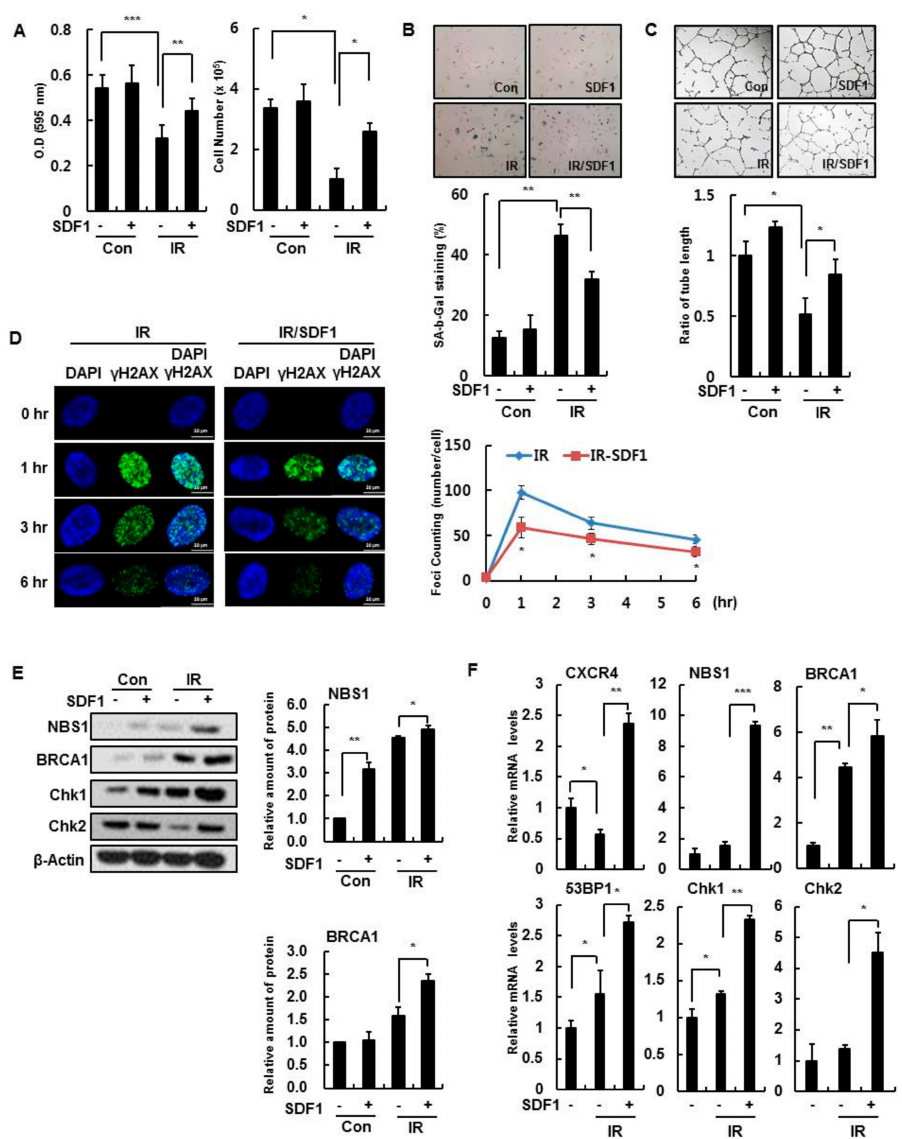
Figure 3. SDF-1 promotes recovery in damaged HBMVECs. ( A ) Cell viability was measured by a 3-(4,5-dimethylthiazol-2-yl)-2,5-diphenyltetrazolium bromide (MTT) assay, and cell proliferation was confirmed by cell count analysis. HBMVECs were pretreated with 50 ng / mL SDF-1 an hour before 4 Gy radiation treatment. MTT was measured 24 h after radiation treatment, and the cell count was analyzed after 4 days. ( B ) Cells were stained for SA- β -gal activity and evaluated using a light microscope (100 × ). Four days after irradiation, staining was performed to analyze SA- β -gal positive cells; results are expressed as a percentage. ( C ) Cells were pretreated with SDF-1 an hour before irradiation for 24 h. Cells were placed on Matrigel, and tube formation was measured after incubating for 8 h. ( D ) HBMVECs were treated with SDF-1 for an hour, irradiated for 0, 1, 3, or 6 h. Cells were immunostained with a γ H2AX antibody to measure foci in more than 100 cells; scale bars = 20 µ m. ( E ) Proteins were isolated 24 h after irradiation, and levels of DNA damage response-related proteins were measured via Western blot analysis. ( F ) Expression levels of DNA damage response-related genes were measured by real-time polymerase chain reaction analysis. Values are expressed as the mean ± standard deviation of three independent experiments. * p < 0.05, ** p < 0.01, and *** p < 0.001. Con, control; IR, ionizing radiation; IR / SDF1, SDF-1, and radiation treated group; γ H2AX, phosphorylated H2A histone family member X; NBS1, Nibrin; BRCA1, Breast cancer type 1 susceptibility protein; Chk, checkpoint